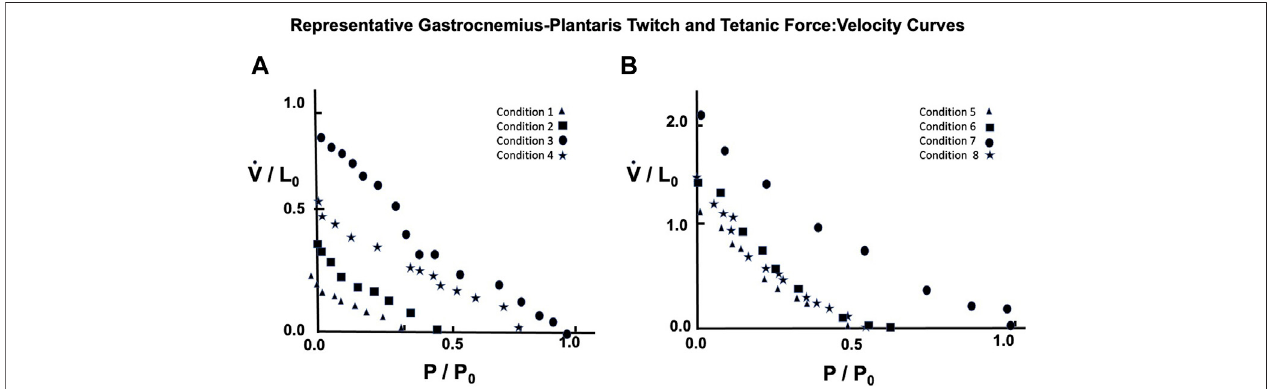
FIGURE 10 | Representative gastrocnemius plantaris Force:Velocity measurements for twitch (A) and brief tetanic (B) stimulation. Each muscle was done under four different stimulus conditions, as described in the text. Conditions 3 and 7 represent the relationship at L i = L 0 and full stimulus intensity. The remaining conditions wereused todeterminetheeffect oflengthand/or activationsonthisrelationship. Conditions1and5weredoneat L i =L 0 ,reducedstimulusvoltage, Conditions2and6 were done at L i < L 0 , reduced stimulus voltage, and Conditions 4 and 8 were done at L i < L 0 , full stimulus voltage.